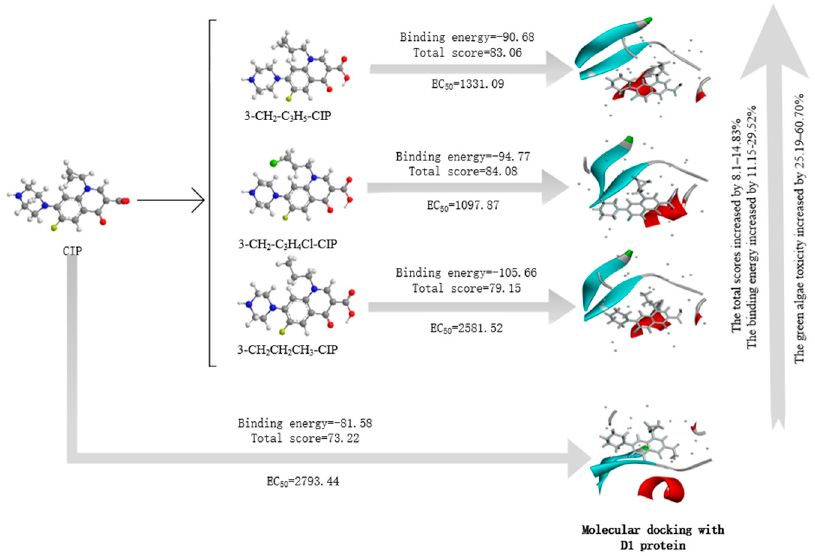
Figure 3. The mechanism of CIP derivatives’ green algae toxicity.